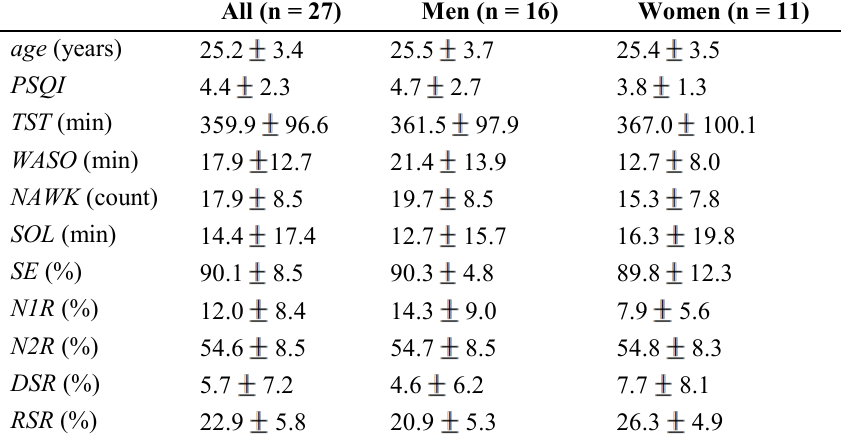
Table 3. Descriptive statistics of the sleep dataset.